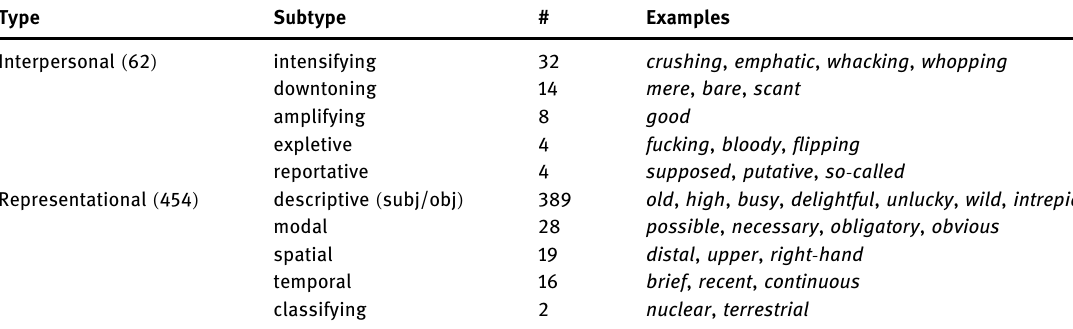
Table 3: Types of modi fi ers